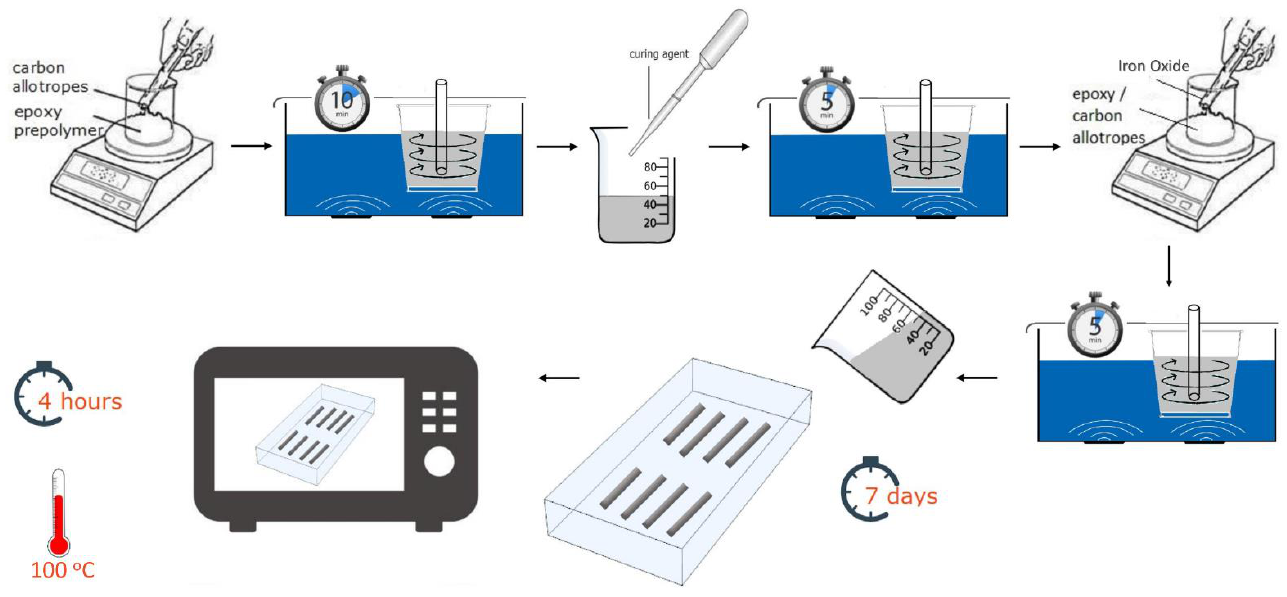
Figure 1. Schematic representation of the fabrication process of the nanocomposites.